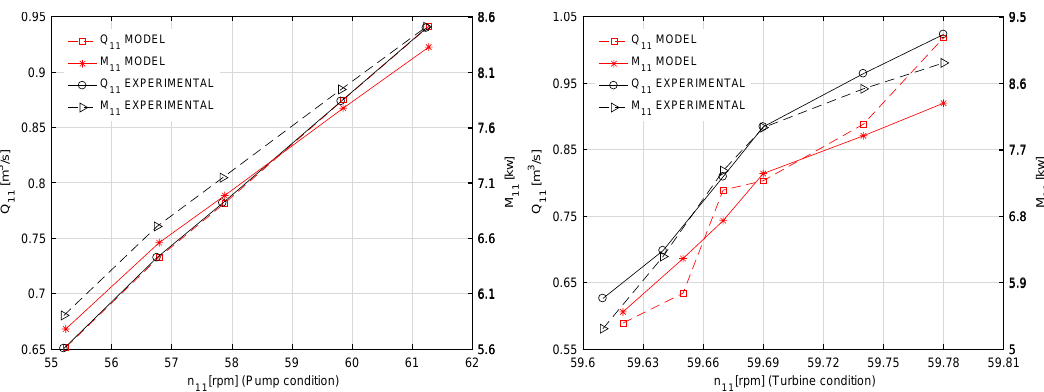
Figure 9. Comparisons of numerical and experimental data, for pump and turbine